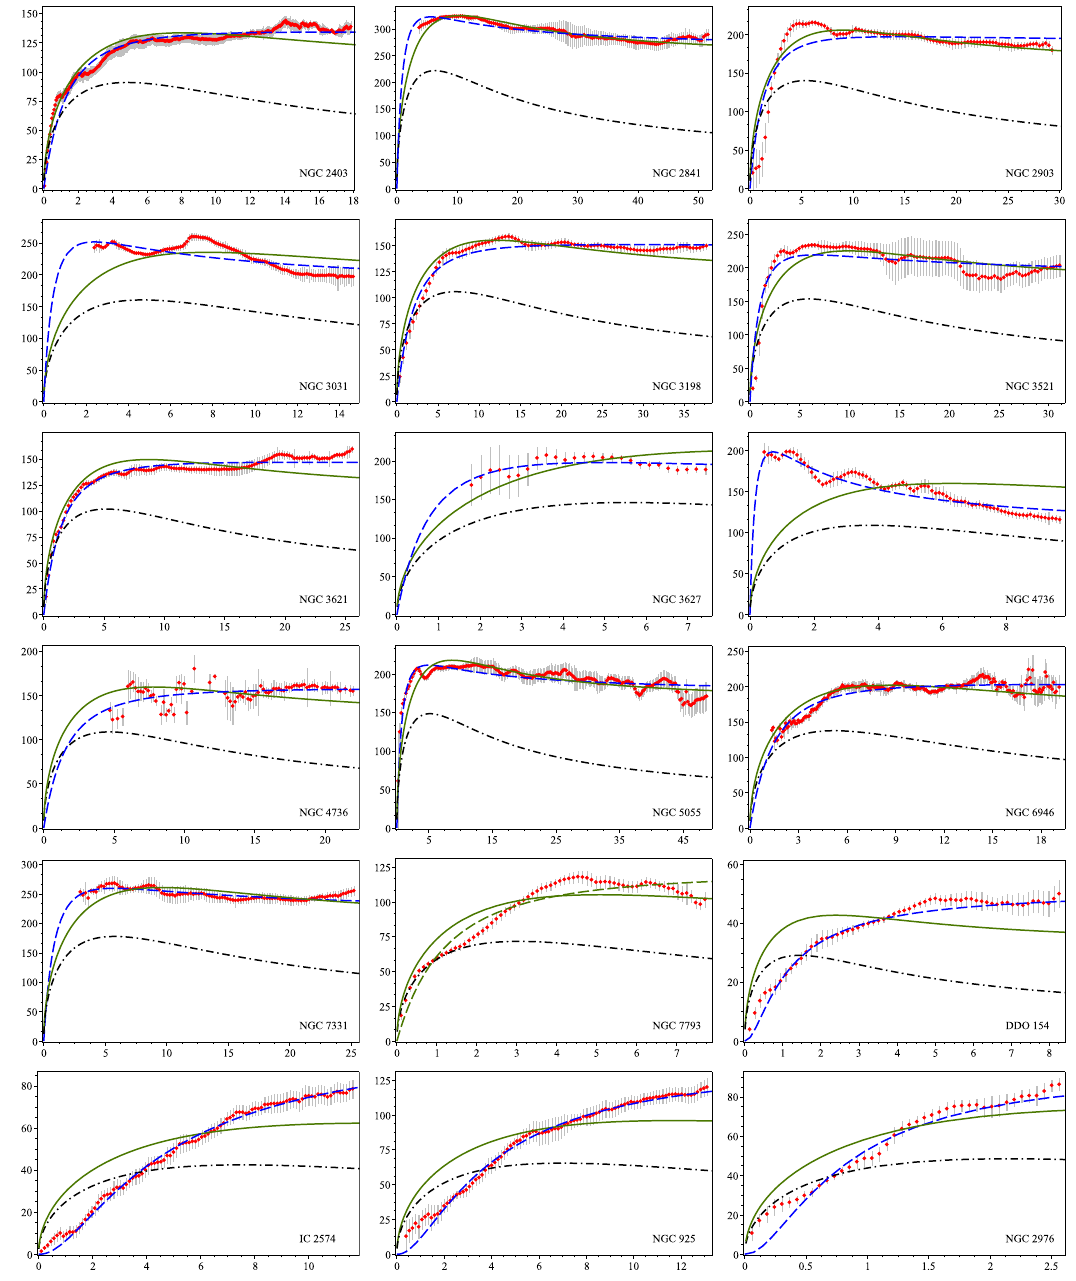
Figure 2. (color online) Rotational velocities in km/s ( y axis) at a certain distance in kpc ( x axis) from the center of the galaxy. The blue curves RC are obtained from the parametric fit of Equation (19) in the case of HSB THINGS galaxies. The full ( green ) curve is the rotation curves obtained using the spherical mass distribution (21); the ( red ) full circles are the observed data points where the vertical ( grey ) lines represent the error bars; the contribution due to the Newtonian term is given by the dash-dotted ( black ) lines, while the dashed ( blue ) lines give rotation curves obtained using the mass distribution in Equation (7). The numerical values resulted from the fits are given in Table